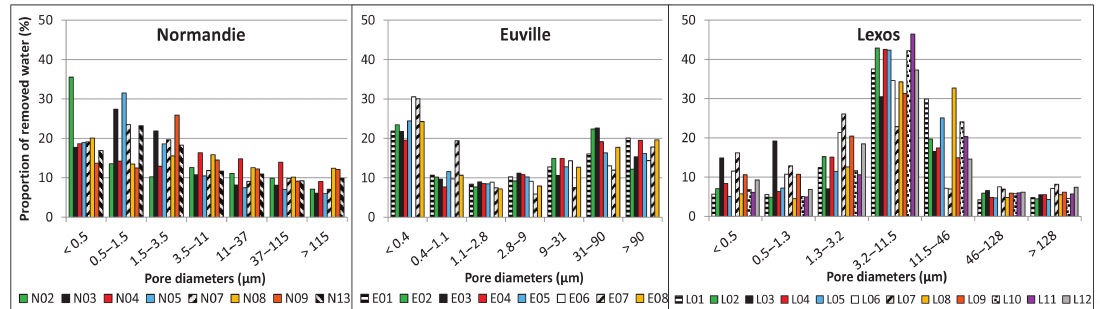
Figure 4. Pore diameters distribution from the centrifugation measurements. Results for Normandie samples are on the left, Euville in the center, Lexos on the